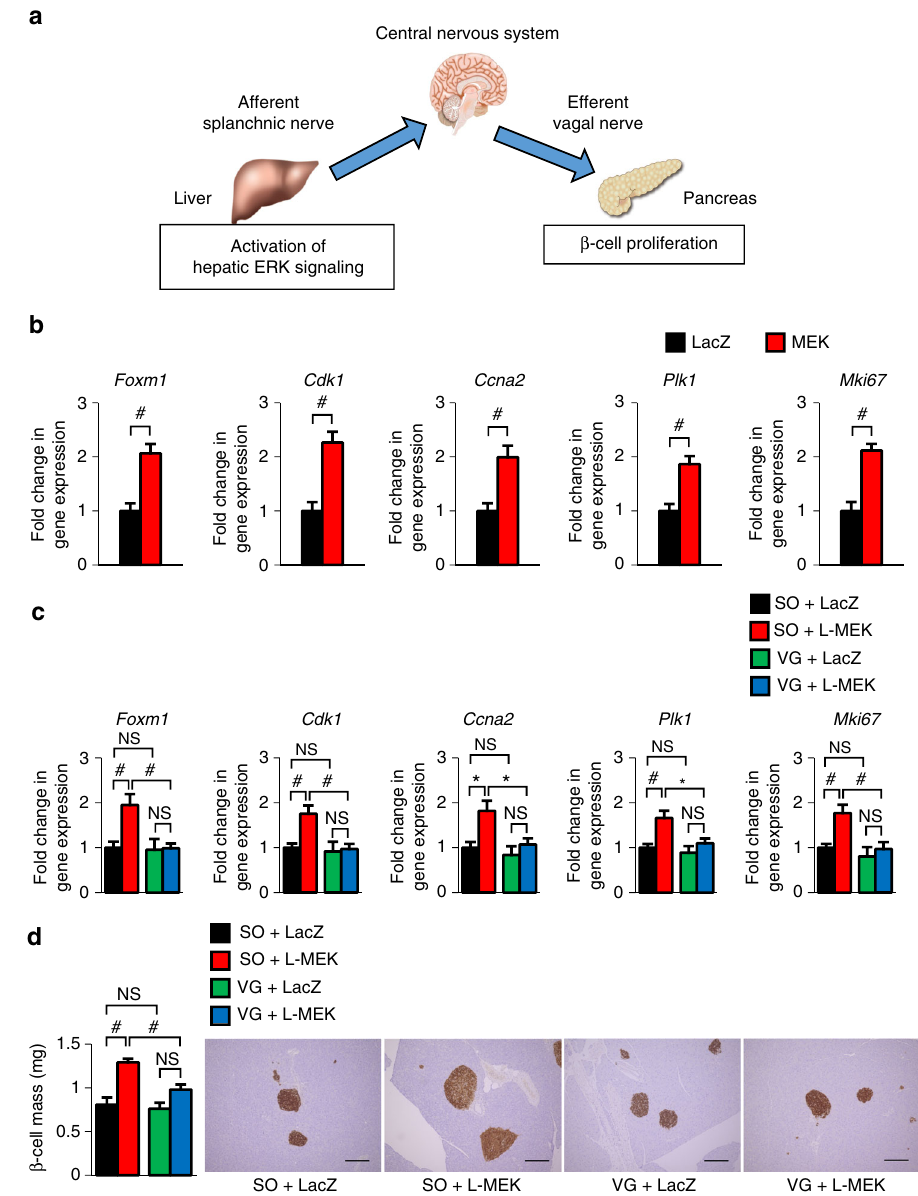
Fig. 1 Hepatic ERK activation increases the expression levels of Foxm1 and its target genes as well as that of the Mki67 gene in islets and induces β -cell proliferation via vagal nerves. a Schematic model of the neuronal relay system from the liver to the pancreas. b Expression levels of Foxm1 and its target genes as well as that of the Mki67 gene in islets of L-MEK-mice or LacZ-injected mice on day 3 after adenoviral administration. c Expression levels of Foxm1 and its target genes as well as that of the Mki67 gene in islets of L-MEK-mice or LacZ-injected mice on day 3 after adenoviral administration, after vagotomy (VG), or sham operation (SO). d β -Cell mass in L-MEK-mice or LacZ-injected mice on day 14 after adenoviral administration, after VG, or SO; representative images are shown in the right four panels. Gene expression levels in islets or β -cell mass of LacZ-injected mice after SO served as controls c , d . Scale bar, 200 µ m. Data are presented as means ± s.e.m. NS, not signi fi cant, * P < 0.05, # P < 0.01, assessed by unpaired t -test b or one-way ANOVA c , d . n = 7 or 8 b , n = 6 – 11 c , n = 7 – 11